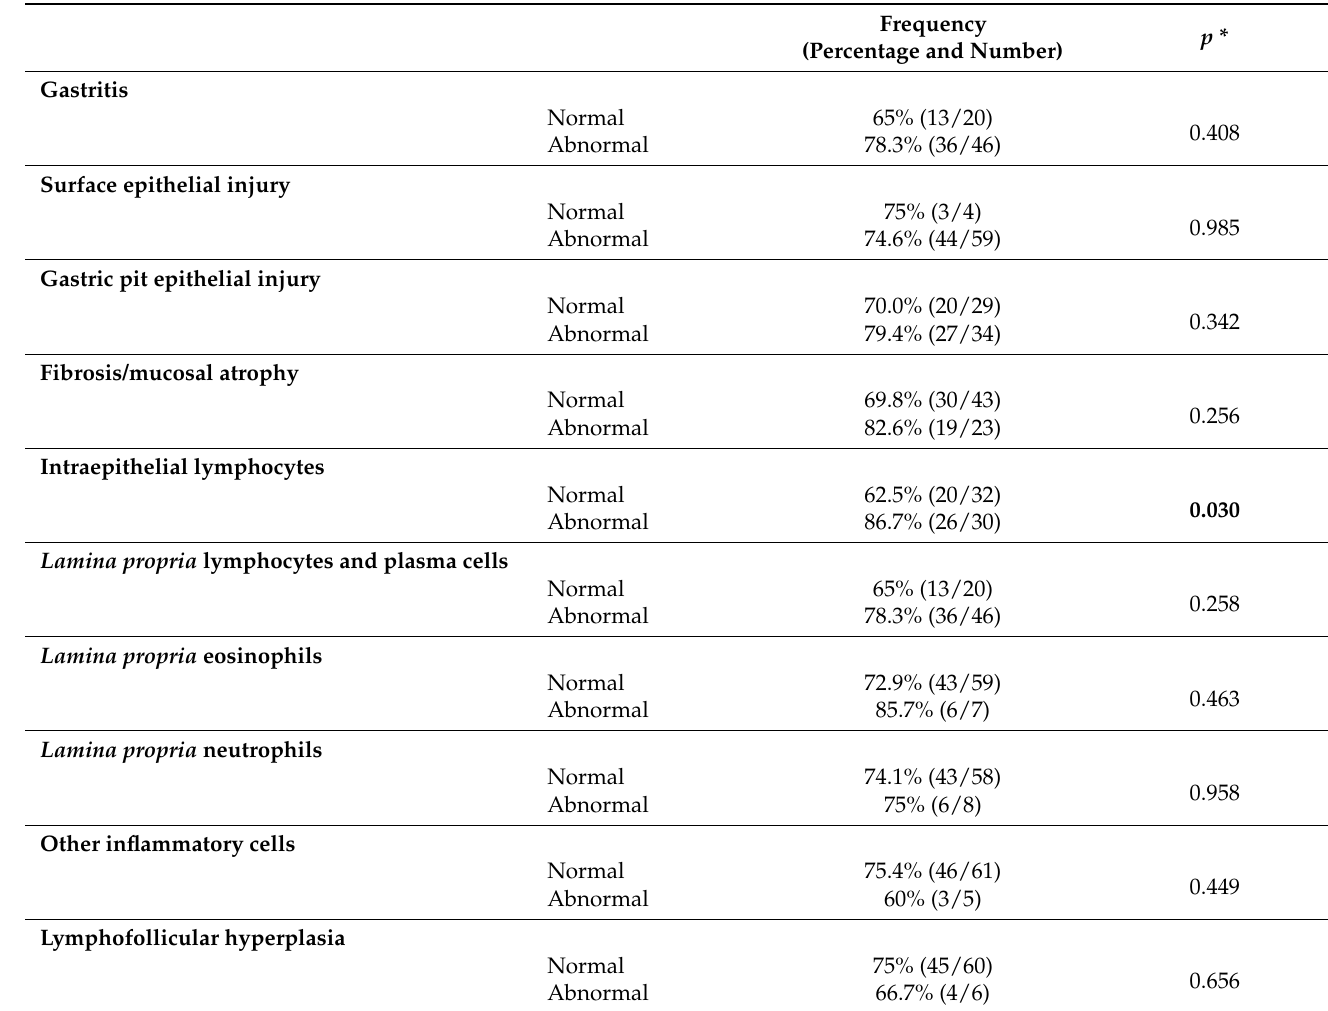
Table 5. Association between gastric histopathological alterations and the presence of Helicobacter spp. in